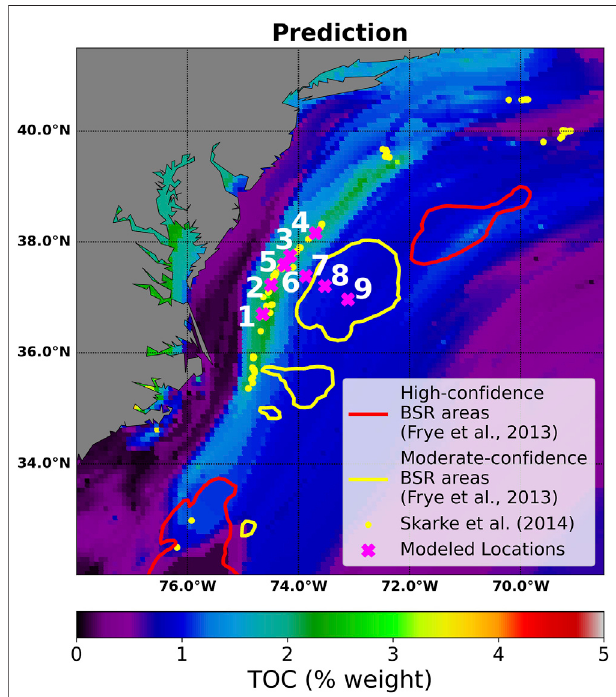
FIGURE 9 | Output maps from GPSM over the area 32 ° N – 41.5 ° N and 78 ° W – 68.5 ° W. Methane seeps (yellow dots) identi fi ed by Skarke et al. (2014) are also plotted and support the increased TOC prediction between (35.4 ° N, 75.0 ° W) and (39.0 ° N, 72.0 ° W). Locations where we modeled hydrate and gas formation are marked with a magenta × and numbered. Red and yellow outlines are areas where the U.S. Bureau of Ocean